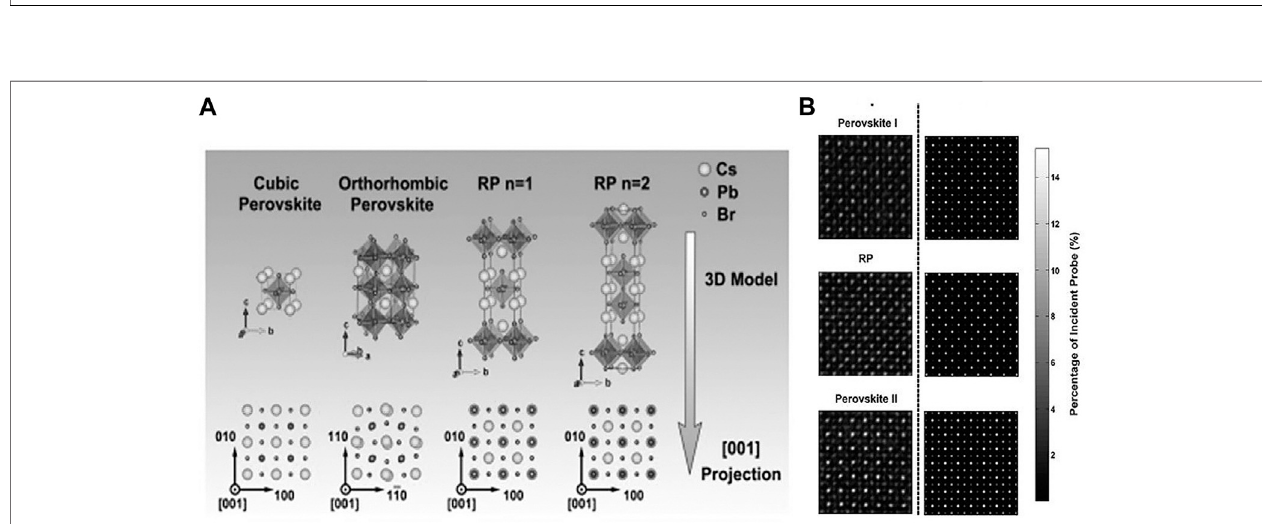
FIGURE 1 | (A) Total publication by year for 2D halide perovskites. (B) Sum of time cited by year in the literature. (C) Total publication by year for 2D halide perovskite solar cells. (D) Sum of time cited by year in the literature.